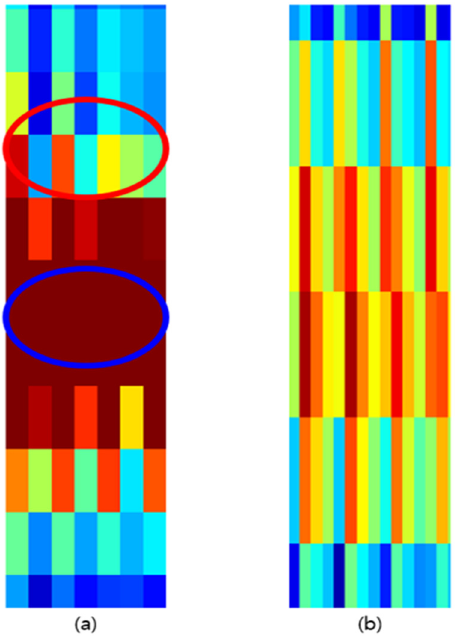
Figure 17. Comparison of ( a ): window length 128 and ( b ): window length 64.